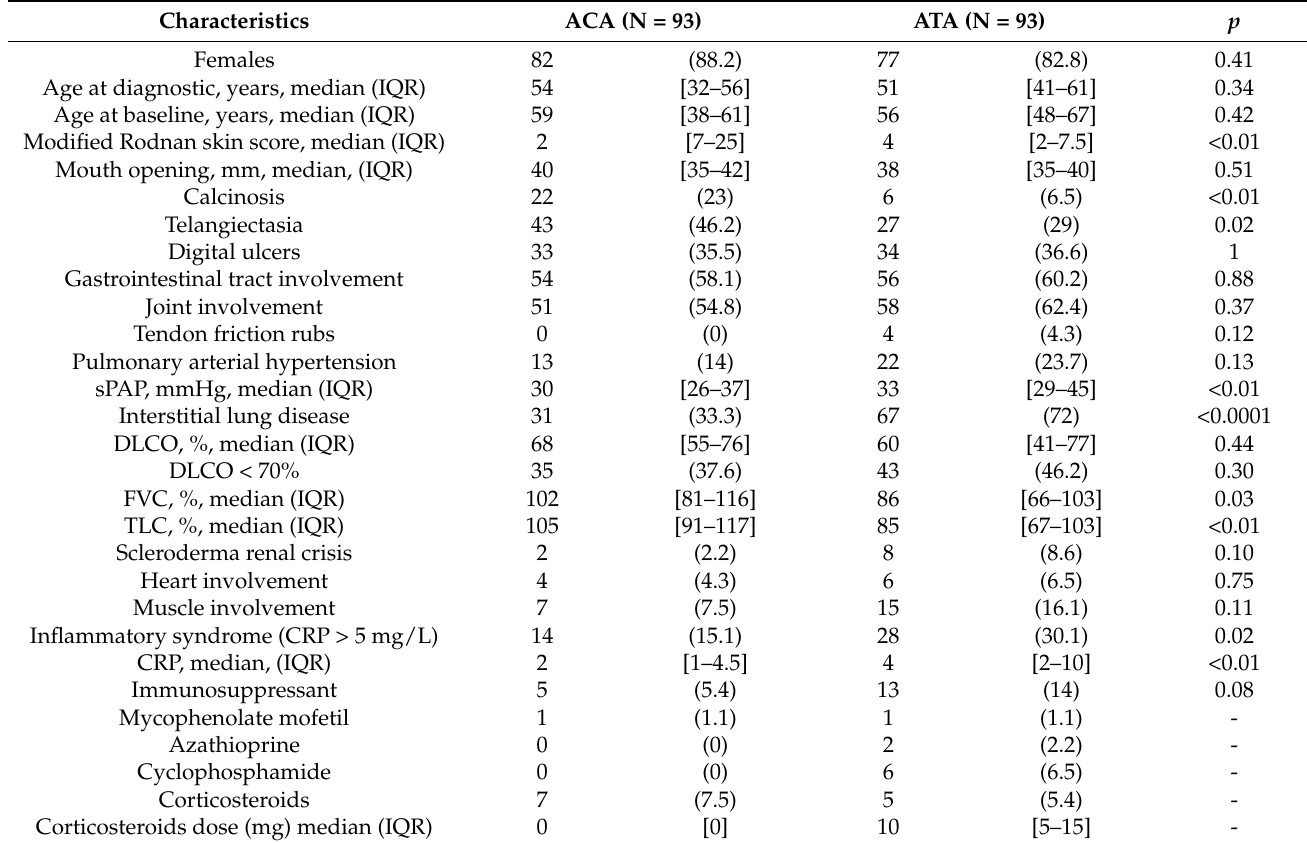
Table 4. Demographic characteristics of patients with limited systemic sclerosis (lSSc).